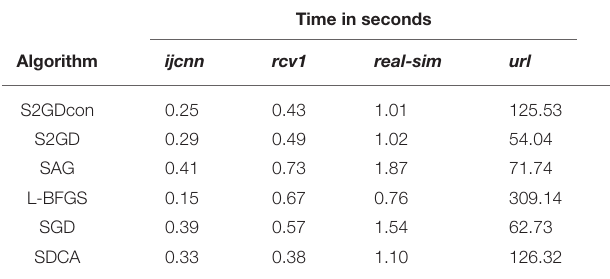
leads to the SVRG method of [7]. We chose parameters m and TABLE 5 | Time required to produce plots in Figure 2. h as a (numerical) solution of the work-minimization problem λ (20), obtaining m 261, 063 and h 1 / 11.4 L for ν = = = and m 426, 660 and h 1 / 12.7 L for ν 0. The practical = = =